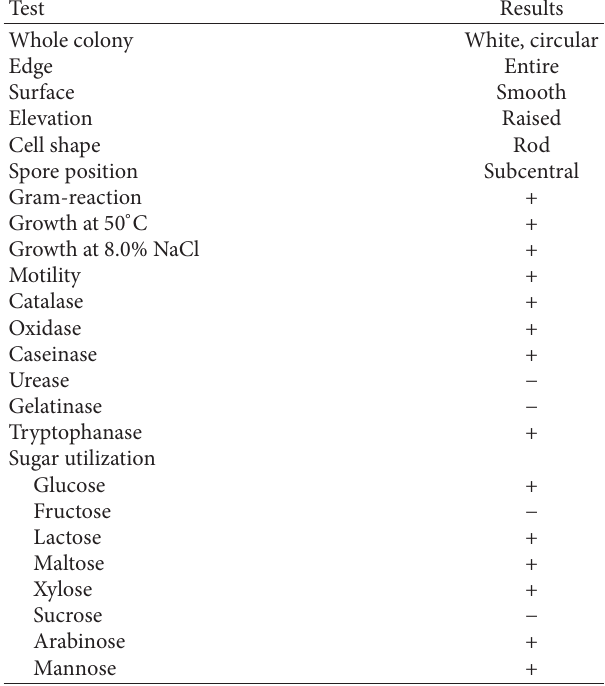
Table 1: Screening test for selecting bacteria with high xylanase producing ability. Isolate no.